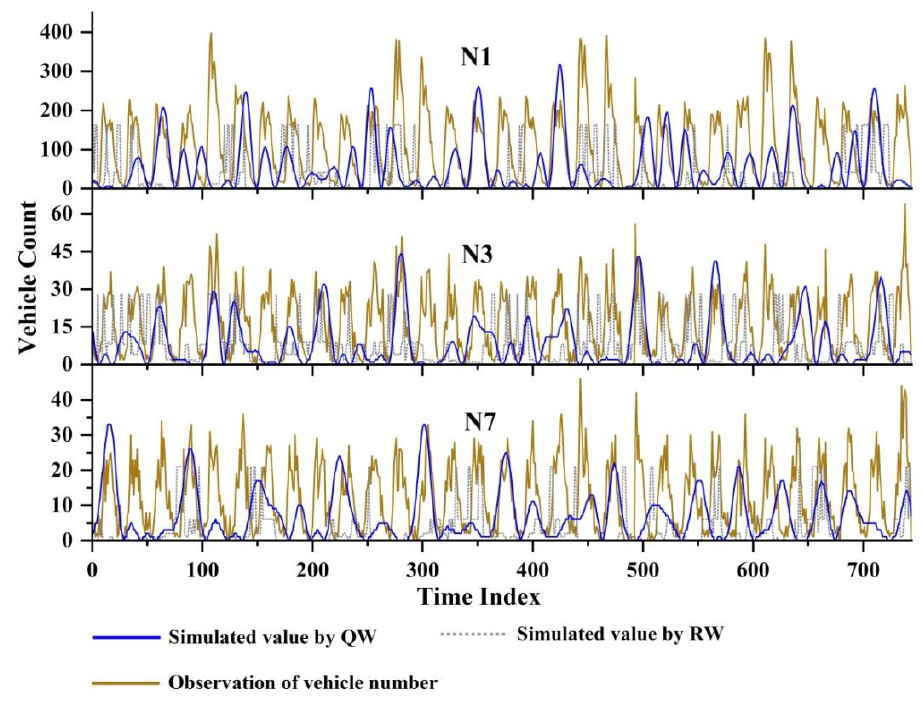
Figure 5. Comparison between simulation results and real observation data.